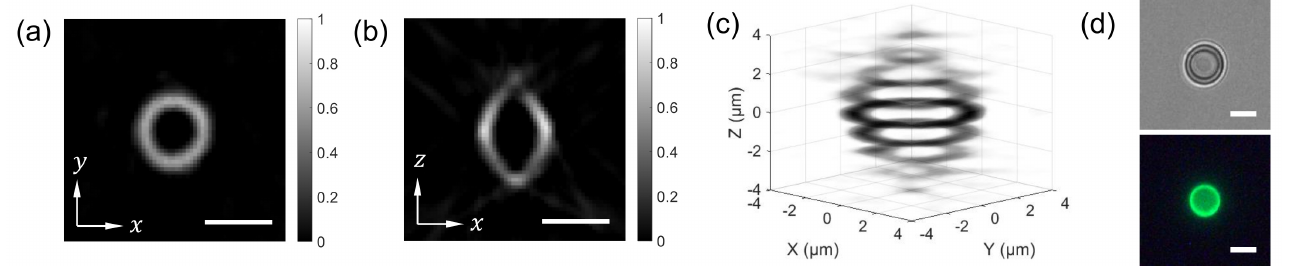
Figure 4. SPOT reconstruction result. For the image shown in Figure 2D, the horizontal ( a ) and vertical ( b ) cross sections of the 6 µ m bead are calculated for the wavelength of 530 nm. ( c ) shows a 3D rendered image of the reconstructed bead. ( d ) A bright field (defocused) and a wide-field fluorescence image of the bead. Scale bars: 5 µ m.